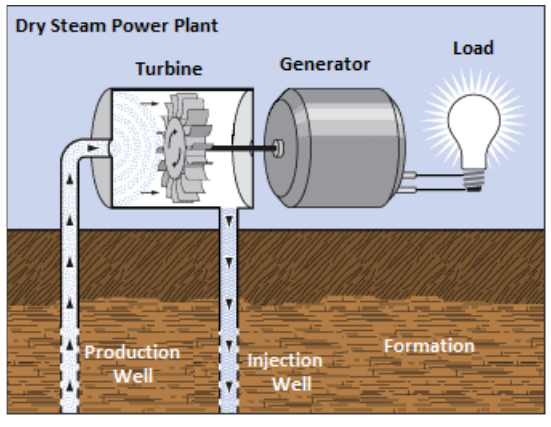
Figure 4. Direct steam power plant [32].